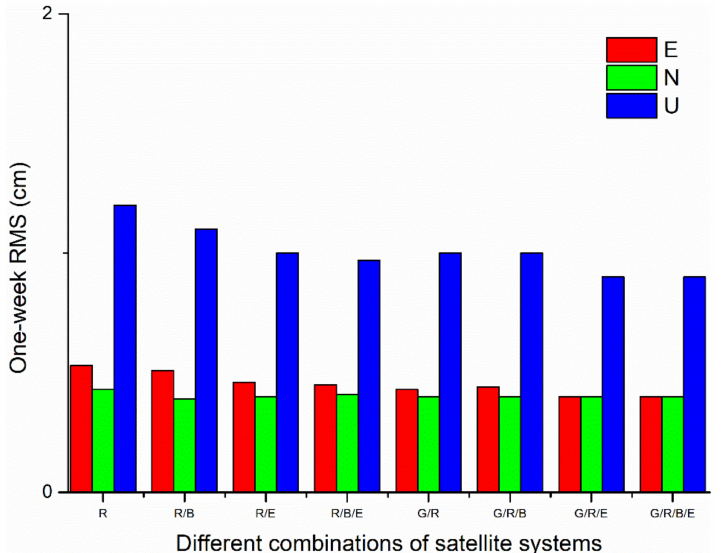
Figure 3. Positioning accuracy of different combined solutions for the NF model in static mode. Note: R, G/R, R/B, R/E, G/R/B, G/R/E, R/B/E, and G/R/B/E denote GLONASS, GPS/GLONASS, GLONASS/BDS, GLONASS/GALILEO, GPS/GLONASS/BDS, GPS/GLONASS/GALILEO, GLONASS/BDS/GALILEO, and GPS/GLONASS/BDS/GALILEO,